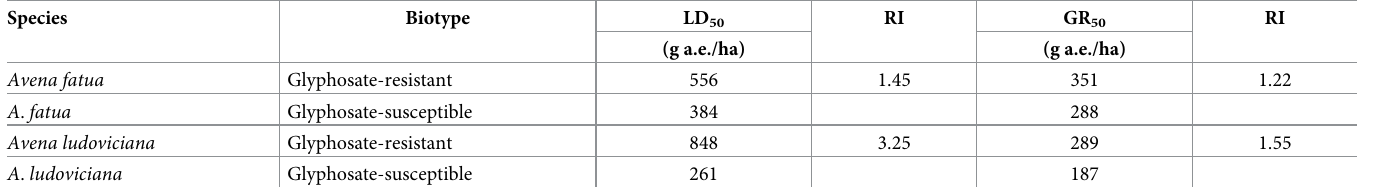
Table 2. Estimated glyphosate dose required to kill 50% of the plants (LD 50 ) of Avena fatua and A . ludoviciana , glyphosate dose required to reduce their biomass by 50% (GR 50 ), and resistance indices